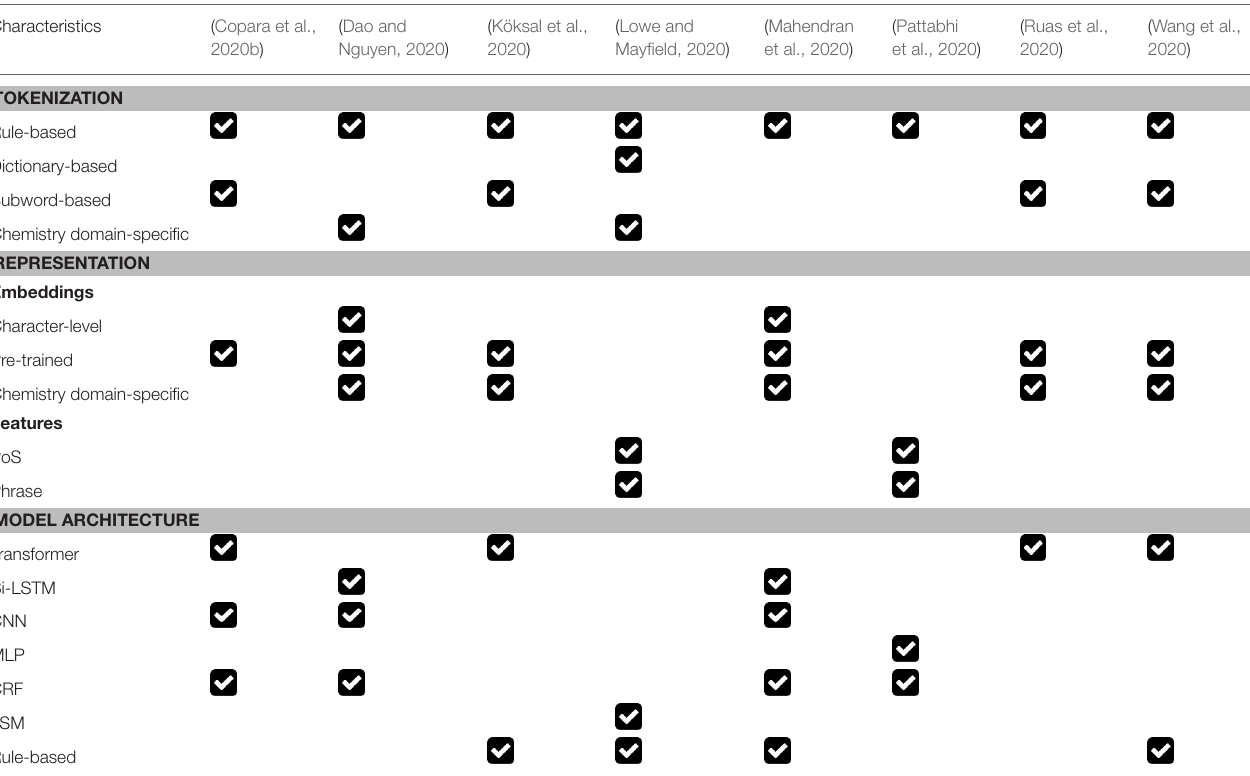
TABLE 11 | Summary of participants’ approaches.